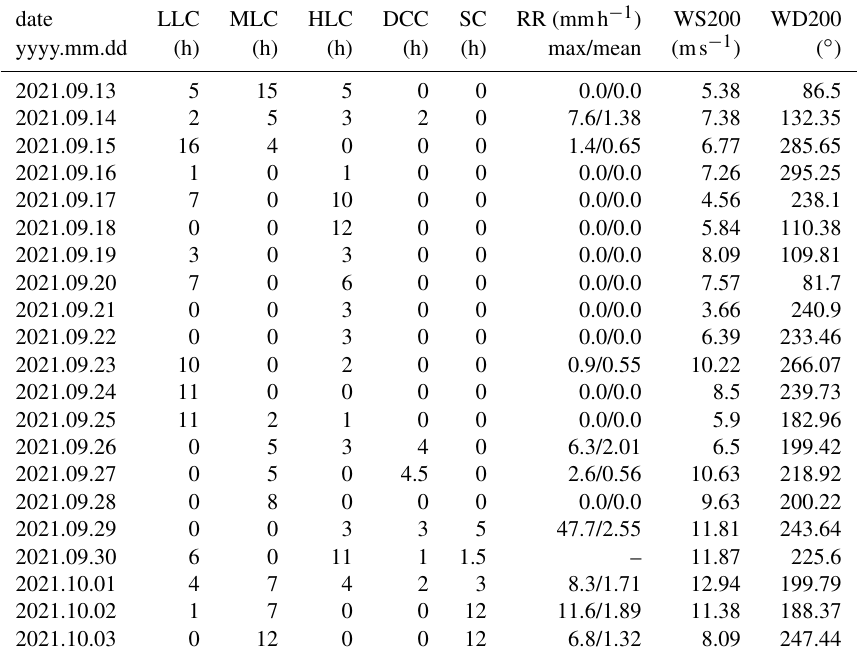
Table 4. Daily characterisation of the cloud coverage and precipitation during CMTRACE. The first five columns (LLC, MLC, HLC, DCC, SC) indicate the approximated duration in hours of each class of clouds. RR indicates the maximum and mean precipitation rate in mmh − 1 measured by a nearby optical disdrometer. WS200 and WD200 are the mean wind speed and direction derived from the WindCube observation at 200ma.g.l. (above the